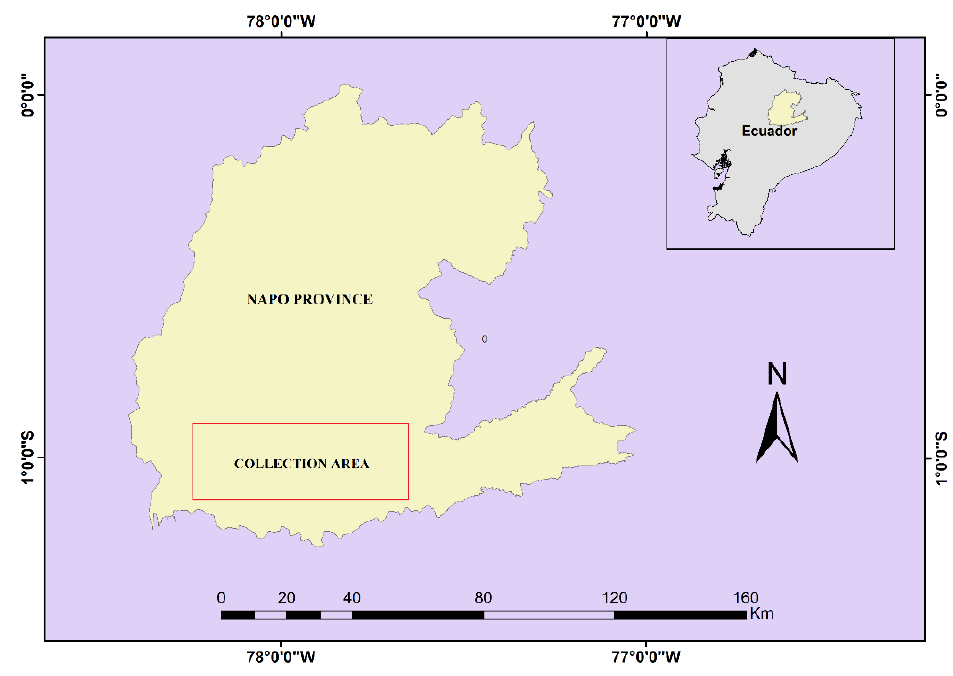
Figure 2. Collection sector of the Ocotea quixos leaves in the Ecuadorian